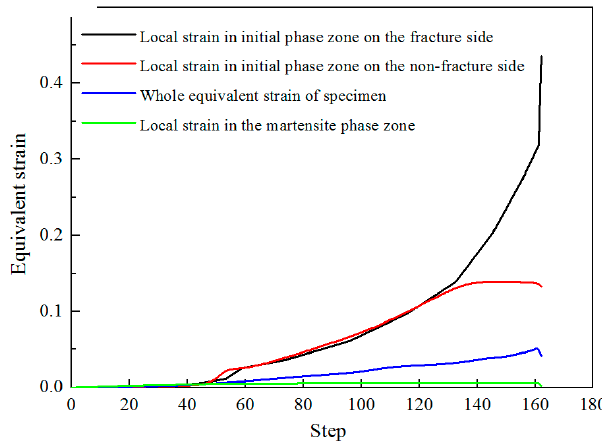
Figure 10. Equivalent strain in different phase regions by virtual extensometer